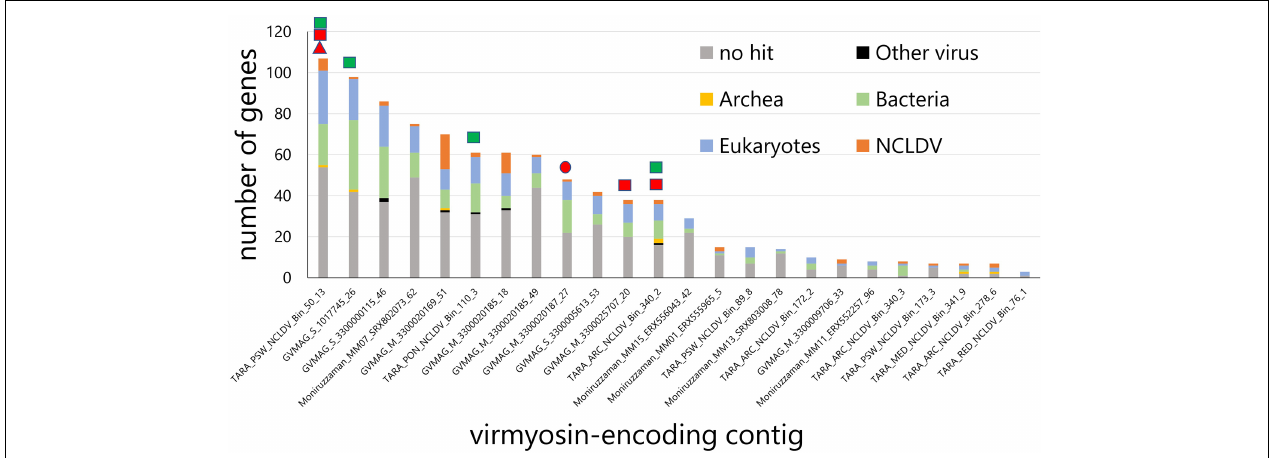
FIGURE 1 | Taxonomic annotation of genes encoded in the virmyosin-harboring NCLDV contigs. Best hit-based taxonomic annotation was performed for each gene using BLAST against the RefSeq database. Identifiers on the x -axis represent the names of MAGs that contain virmyosin-encoding contigs. Marks above the bars indicate the presence of NCLDV core genes in the corresponding contigs, including Poxvirus Late Transcription Factor VLTF3 like (red triangle), major capsid protein (red circle), RNA polymerase subunit alpha (red rectangle), and RNA polymerase subunit beta (green rectangle).